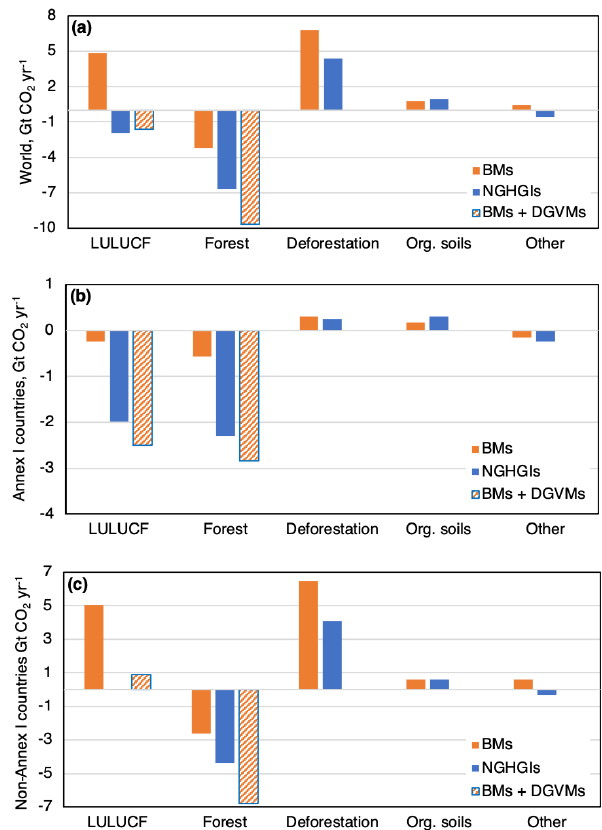
Figure 8. Land CO 2 fluxes (average 2000–2020) from BMs, from the sum of BMs and DGVMs (in non-intact forest only) and from NGHGIs for the total LULUCF sector, forest land (including har- vested wood products and excluding organic soils), deforestation, organic soils and other (cropland, grassland, etc.) at the global level (panel a ), for Annex I countries (b) , and for Non-Annex I countries (c)